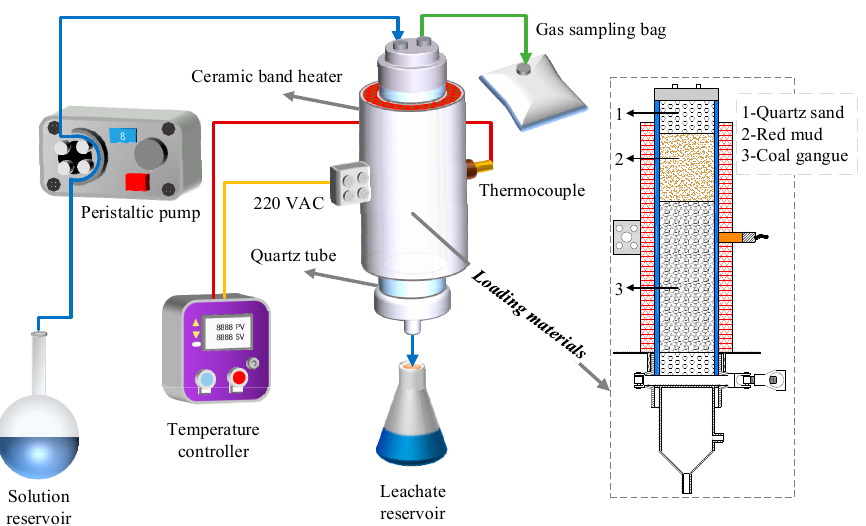
Figure 1. Schematic diagram of the automatic temperature-controlled leaching system and material loading.